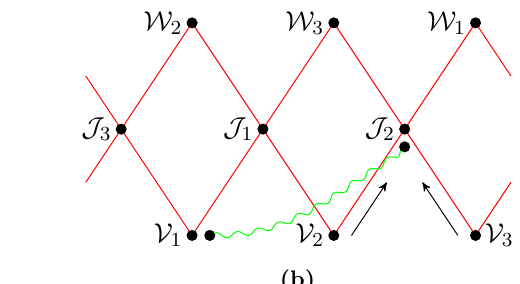
and V can be collected to prepare an EPR pair with V 2 3 : V ) is large, given by the connected wedge 1 2 V 3